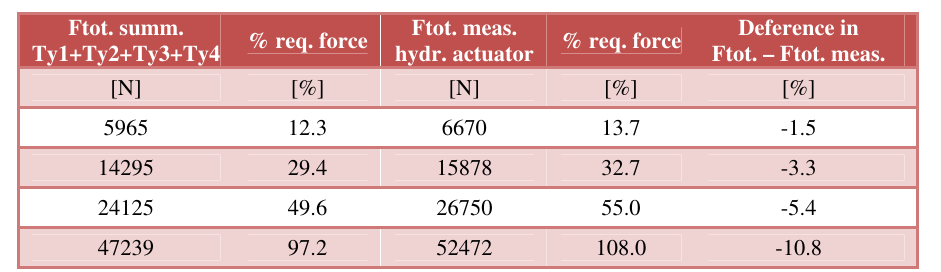
Table 5. Forces in the individual cuts during the test (required and really reached) – case manoeuvre of vertical surfaces % req. F ML F wall 3 force F ML